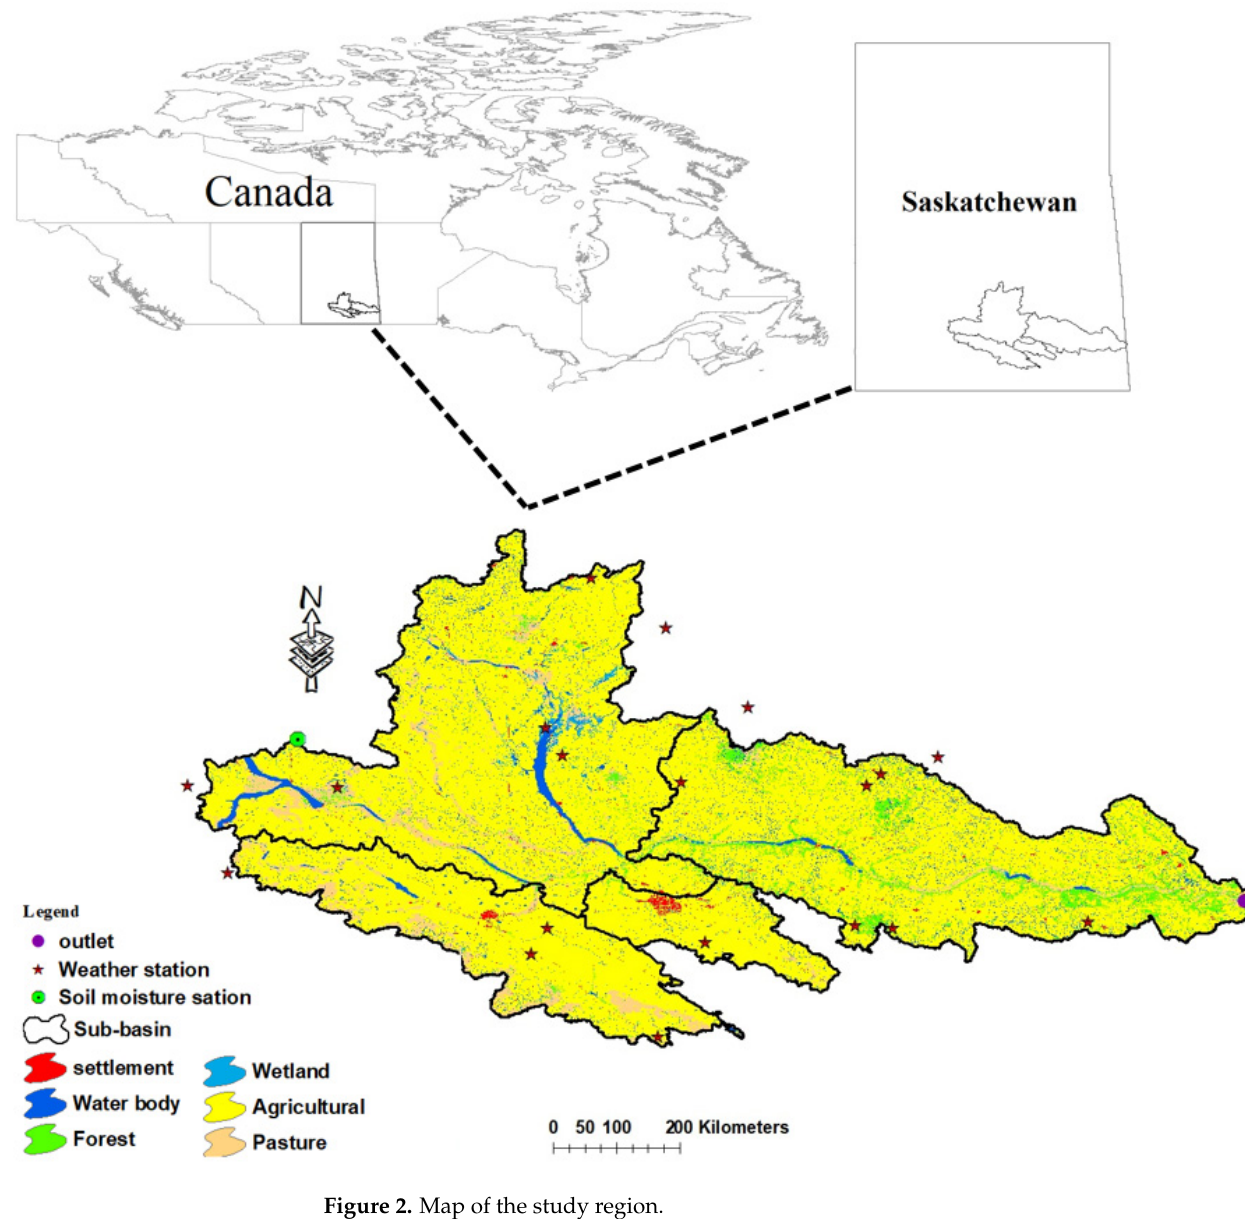
Figure 2. Map of the study region.